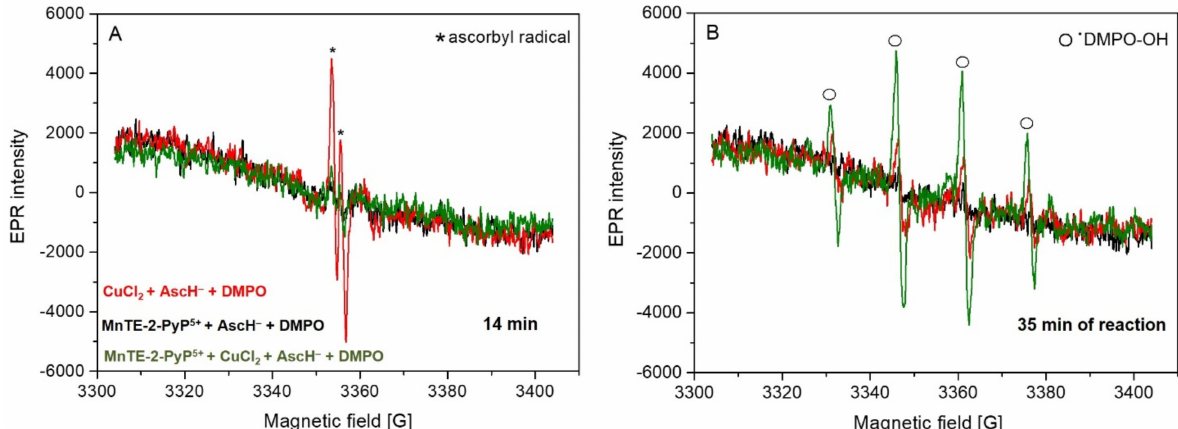
Figure 4. EPR spectra monitored after ( A ) 14 min and ( B ) 35 min of reaction in the aqueous solutions saturated with oxygen at room temperature for the following systems: System 1 (black traces): 7.5 µ M MnTE-2-PyP 5+ + 0.75 mM AscH − + 0.053 M DMPO; System 2 (red traces): 7.5 µ M CuCl 2 + 0.75 mM AscH − + 0.053 M DMPO; System 3 (green traces): 7.5 µ M MnTE-2-PyP 5+ + 7.5 µ M CuCl 2 + 0.75 mM AscH − + 0.053 M DMPO); (*—ascorbyl radical,